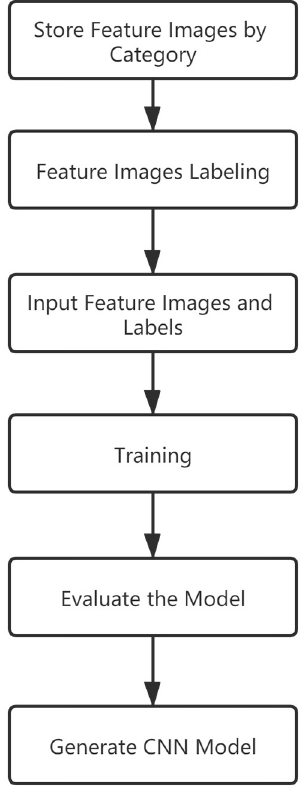
Figure 4. The process of labeling and training.